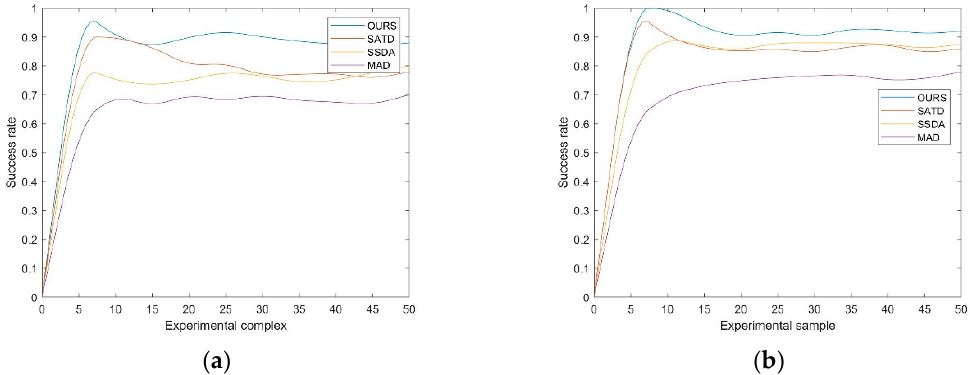
Figure 5. For the complex and simple sets, we compare our method with several classical methods. The subfigures ( a ) shows the performance of each method in complex sets, and ( b ) show the result in sample sets.